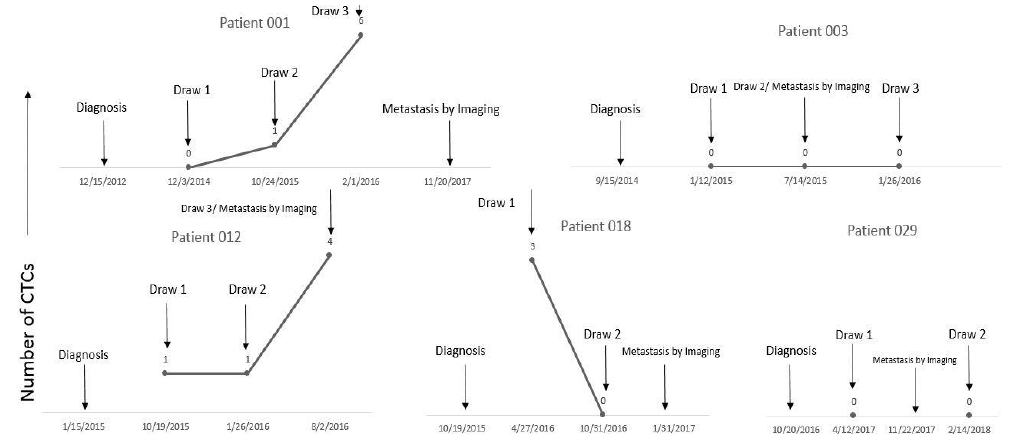
Figure 2. Three out of five patients who developed distant metastasis had CTCs detected before radiographic detection of metastasis. Patients 001, 012, and 018 had CTCs detected 24.9, 9.5 and 3.2 months prior to radiographic evidence of metastasis, respectively. Patient 003 and 029 were “non-secretors” for CTCs as they had no CTC detected pre and post metastasis detection by radiographic imaging.